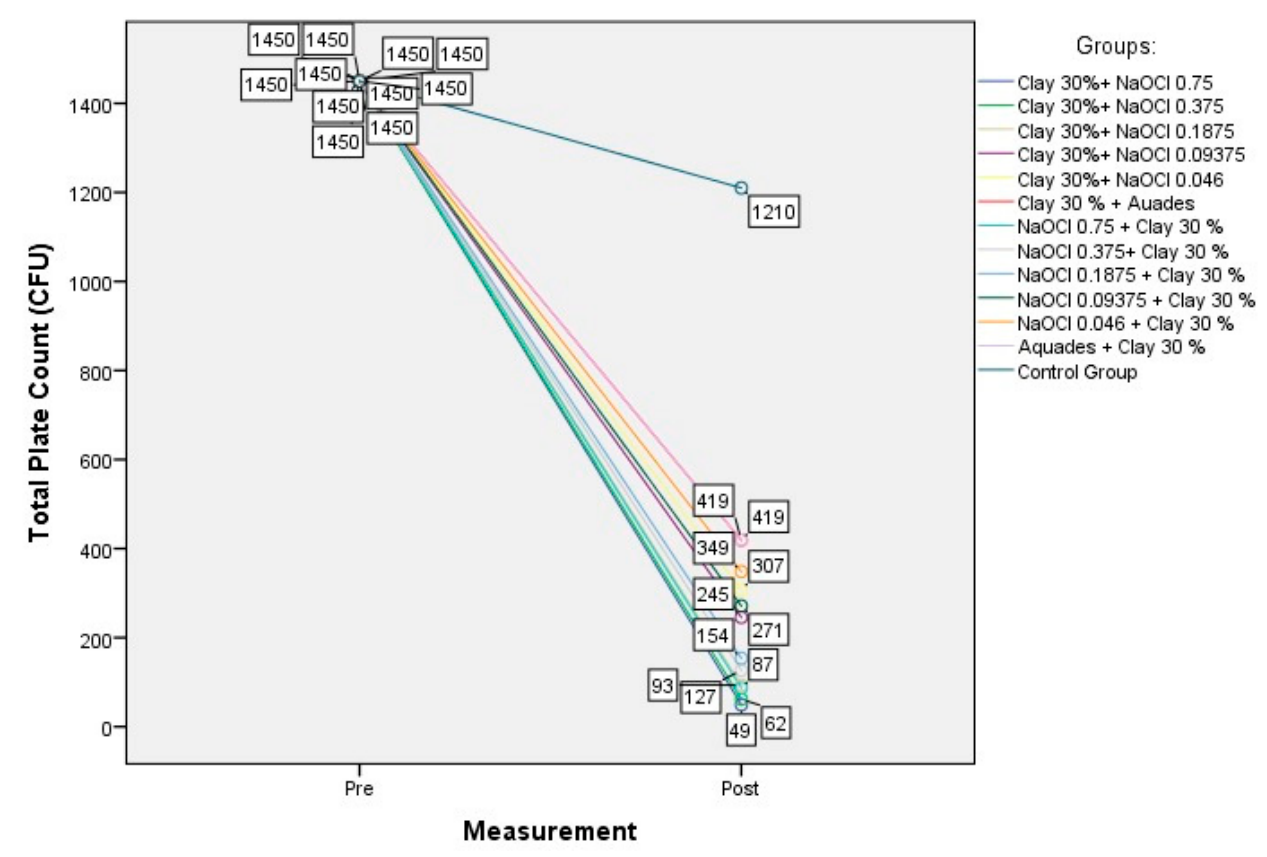
Figure 2. Bacteria reduction before and after treatment.